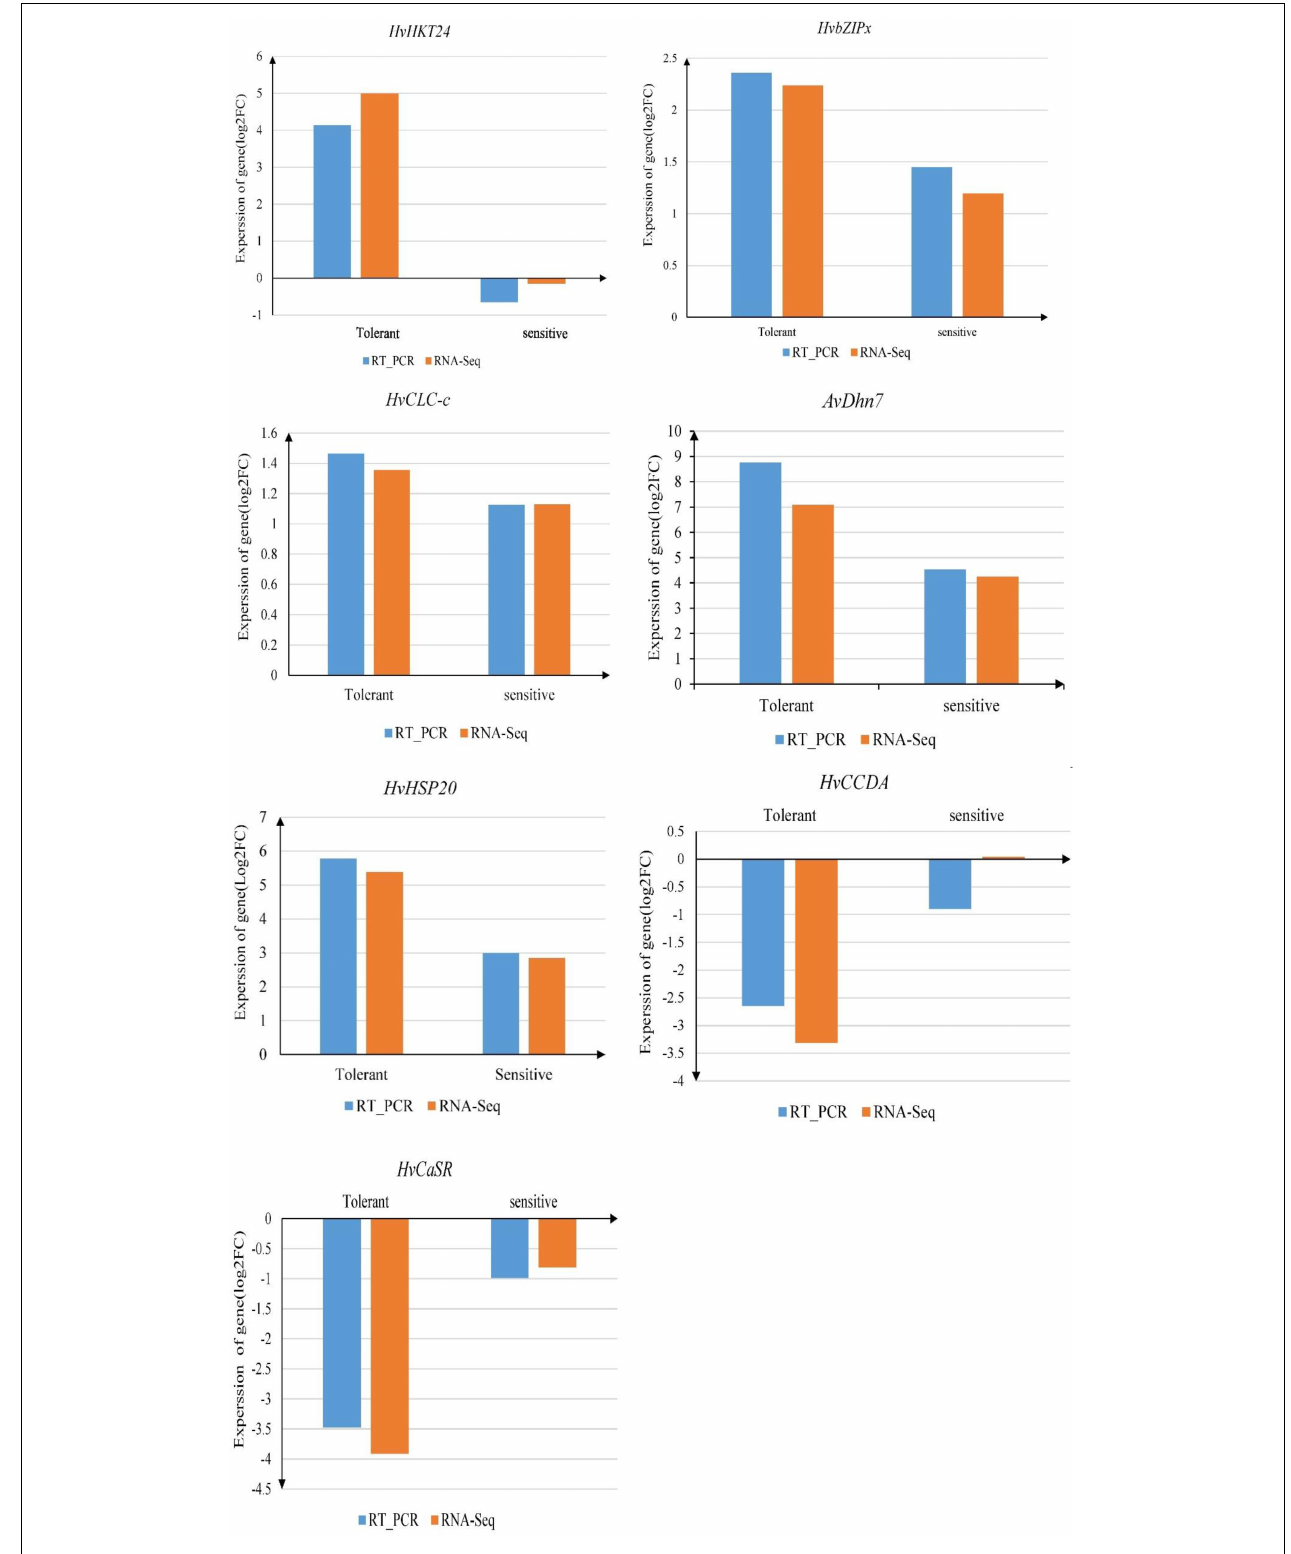
FIGURE 8 | Relative expression of seven genes ( HvKT24 , HvbZIPx , HvCLC-c , AvDhn7 , HvHSP20 , HvCCD , and HvCaSR ), which were also detected by RNA-Seq, using qRT-PCR.